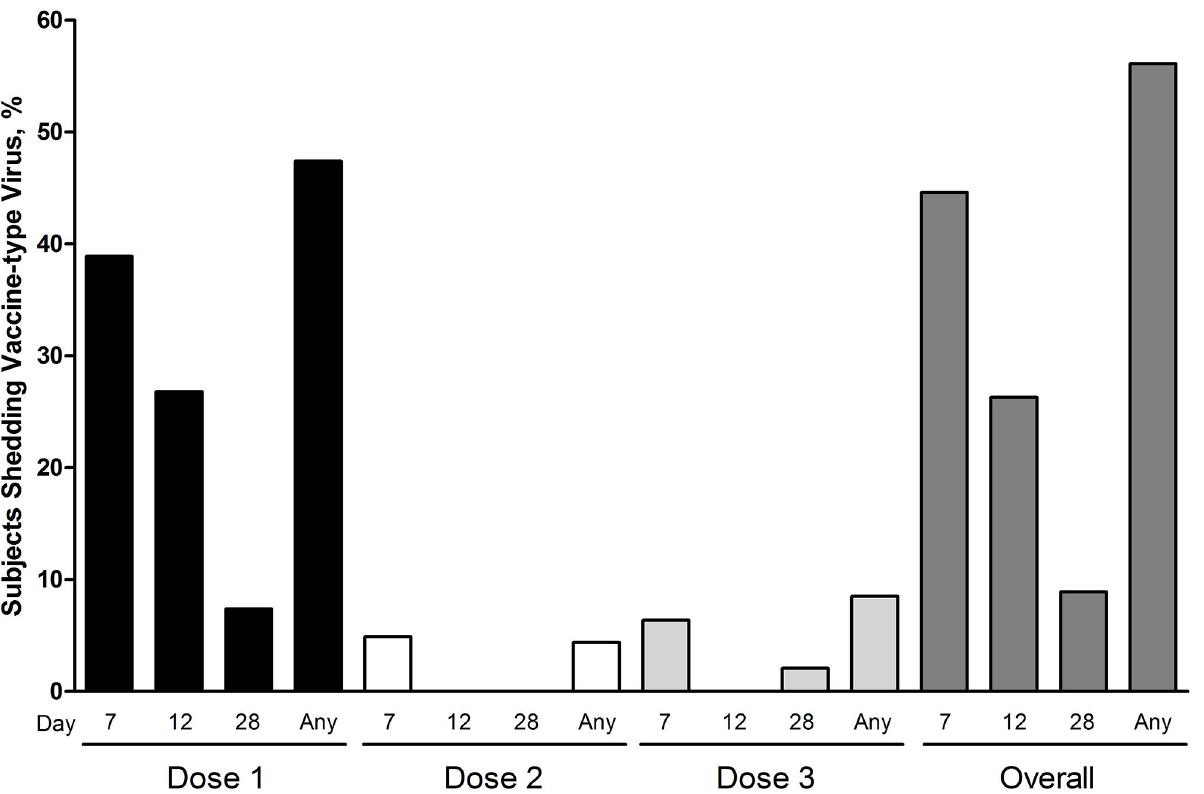
Figure 2. Proportion of MEDI-559 recipients who shed vaccine-type virus, stratified by study visit. doi: